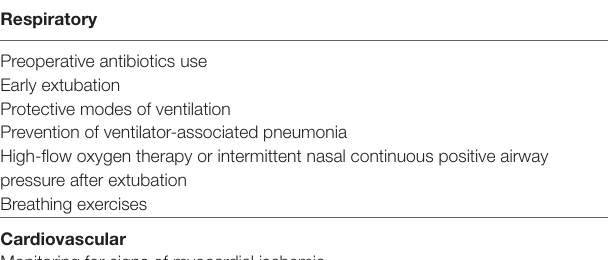
Table 1 | Recommendations for enhanced recovery program in vascular